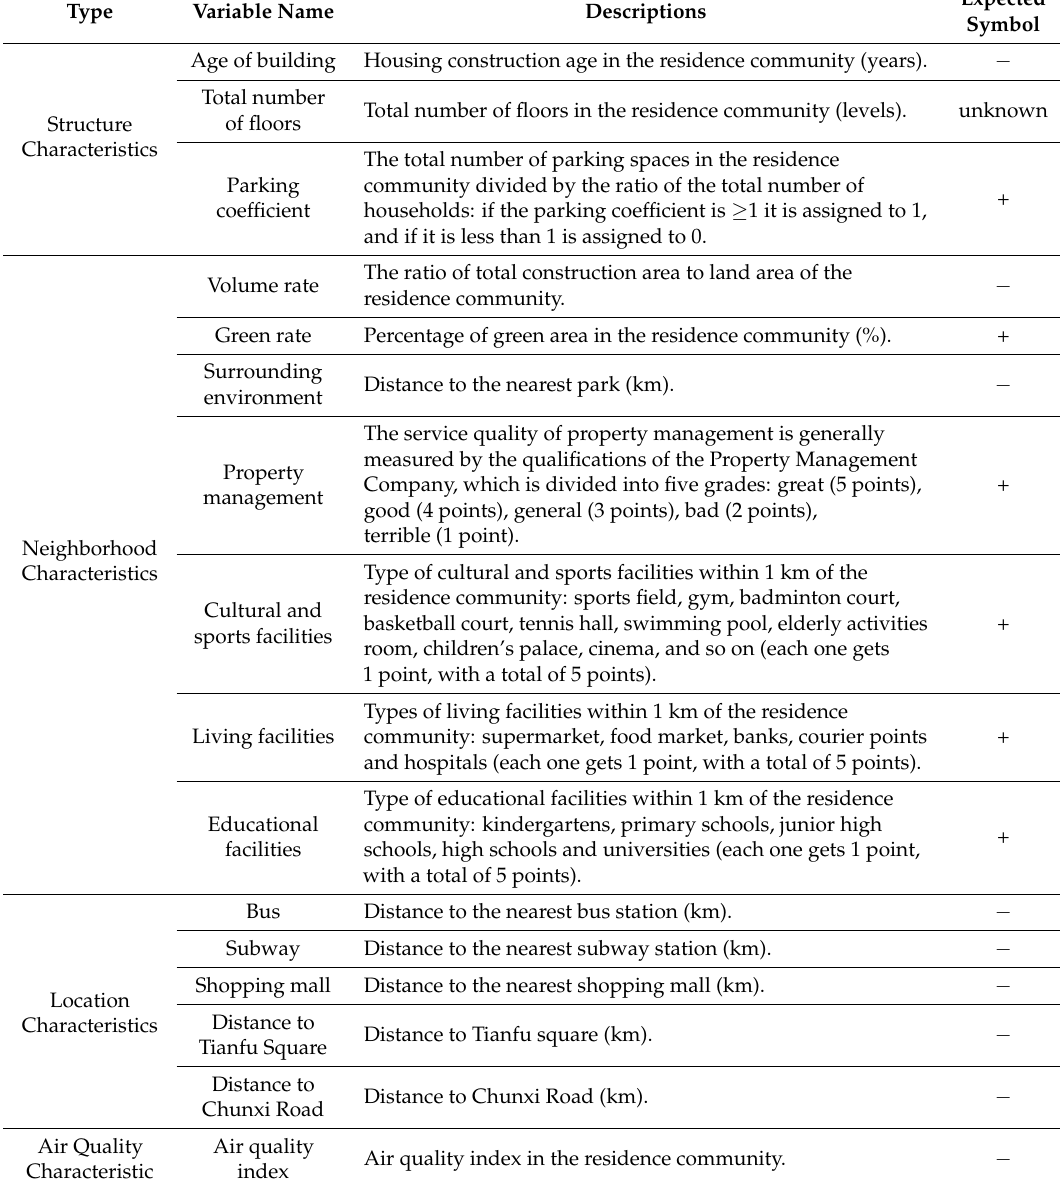
Table 2. Variable definition and expected